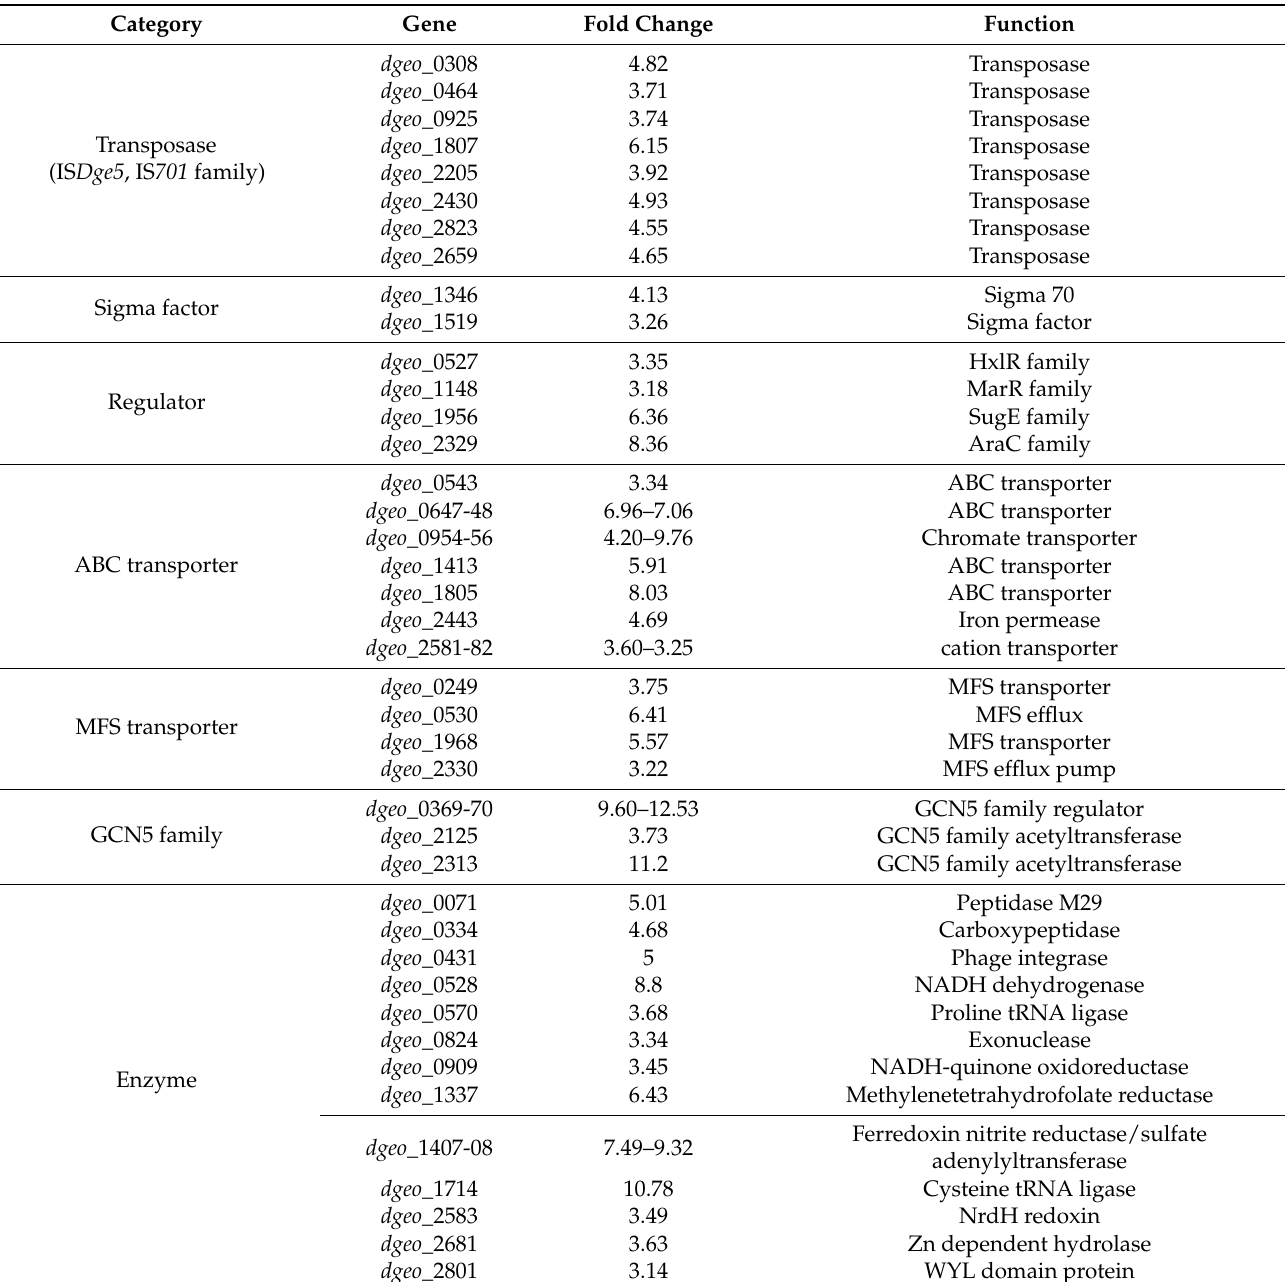
Table 1. List of up-regulated genes (>3.0-fold increase) in the cystine importer-disrupted mutant. Category Gene Fold Change Function